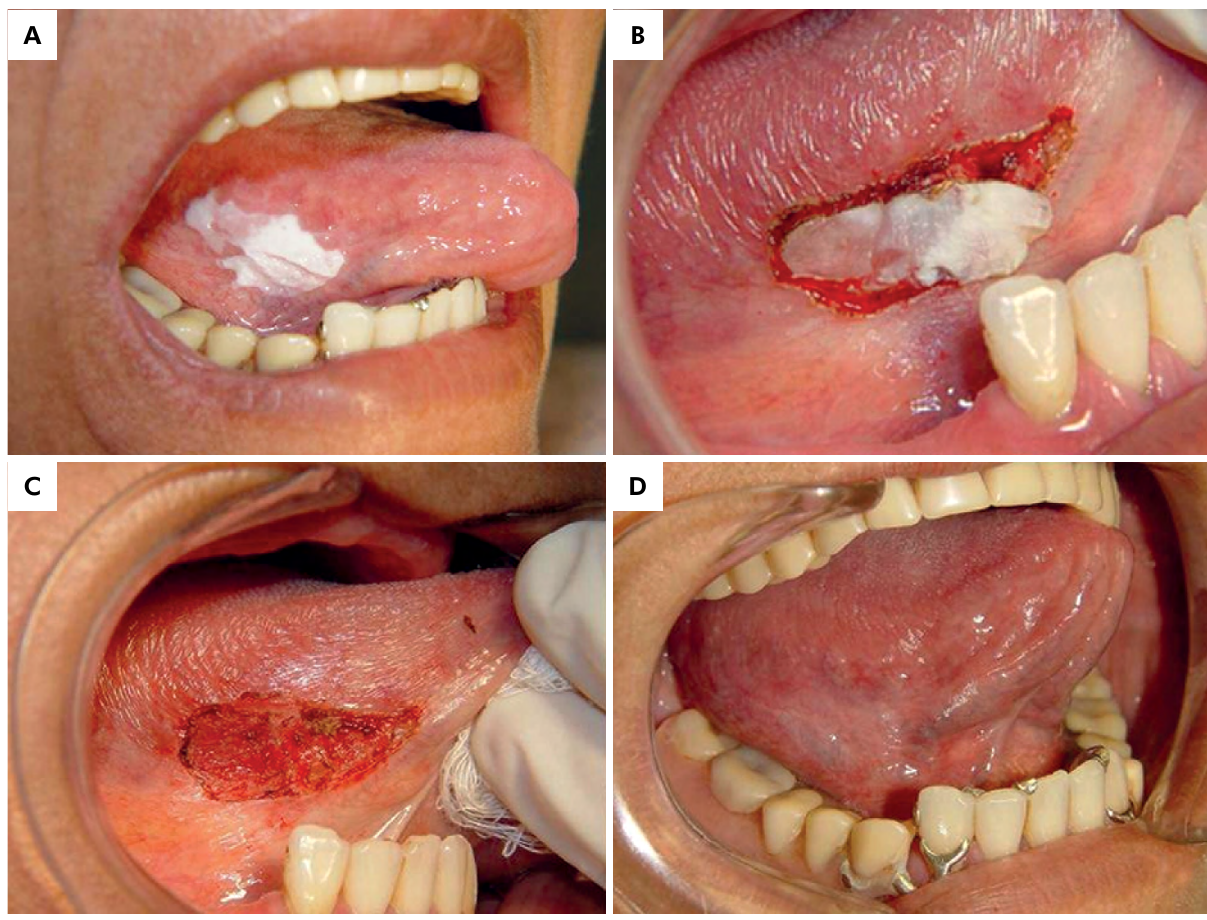
Figure 1. CO laser technique. a) Leukoplakia on the lateral border of the tongue. b) Demarcation of the lesion. c) Complete 2 excision of the lesion. d) Complete healing after 30 days.